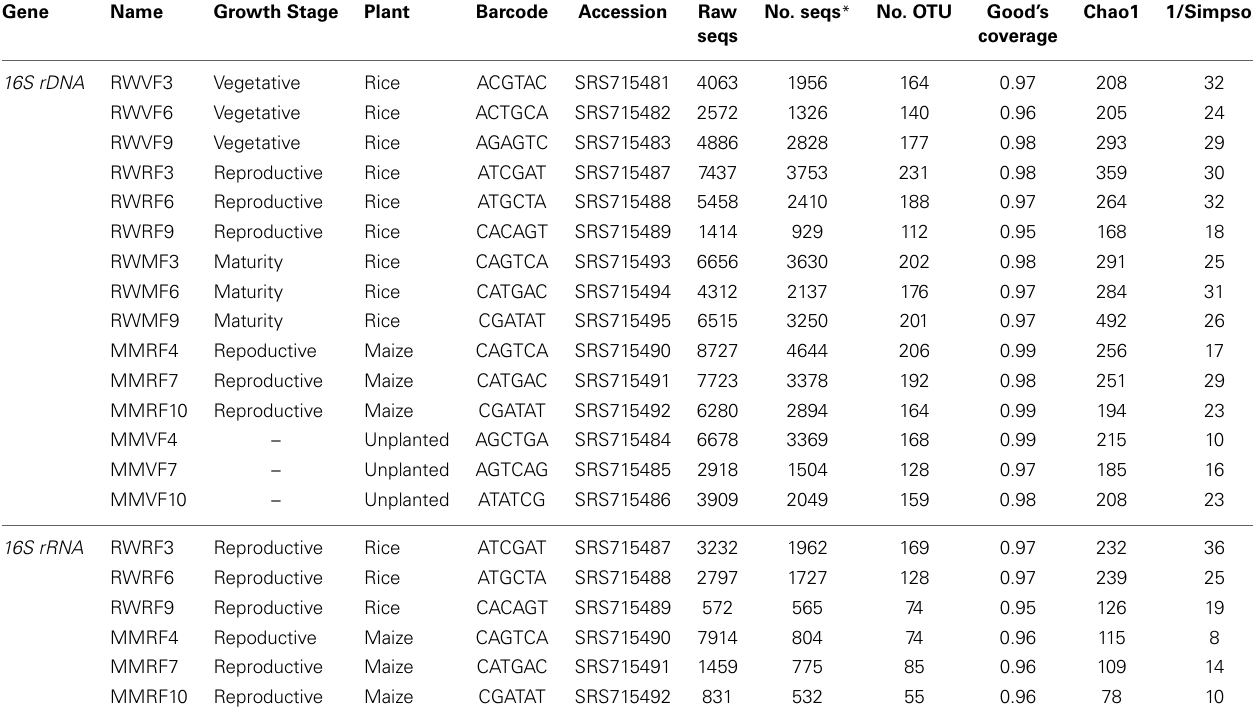
Table 3 | Number of archaeal sequences before and after quality management, barcode, number of OTUs, coverage, Chao1 and inverted Simpson index of the environmental samples analyzed by